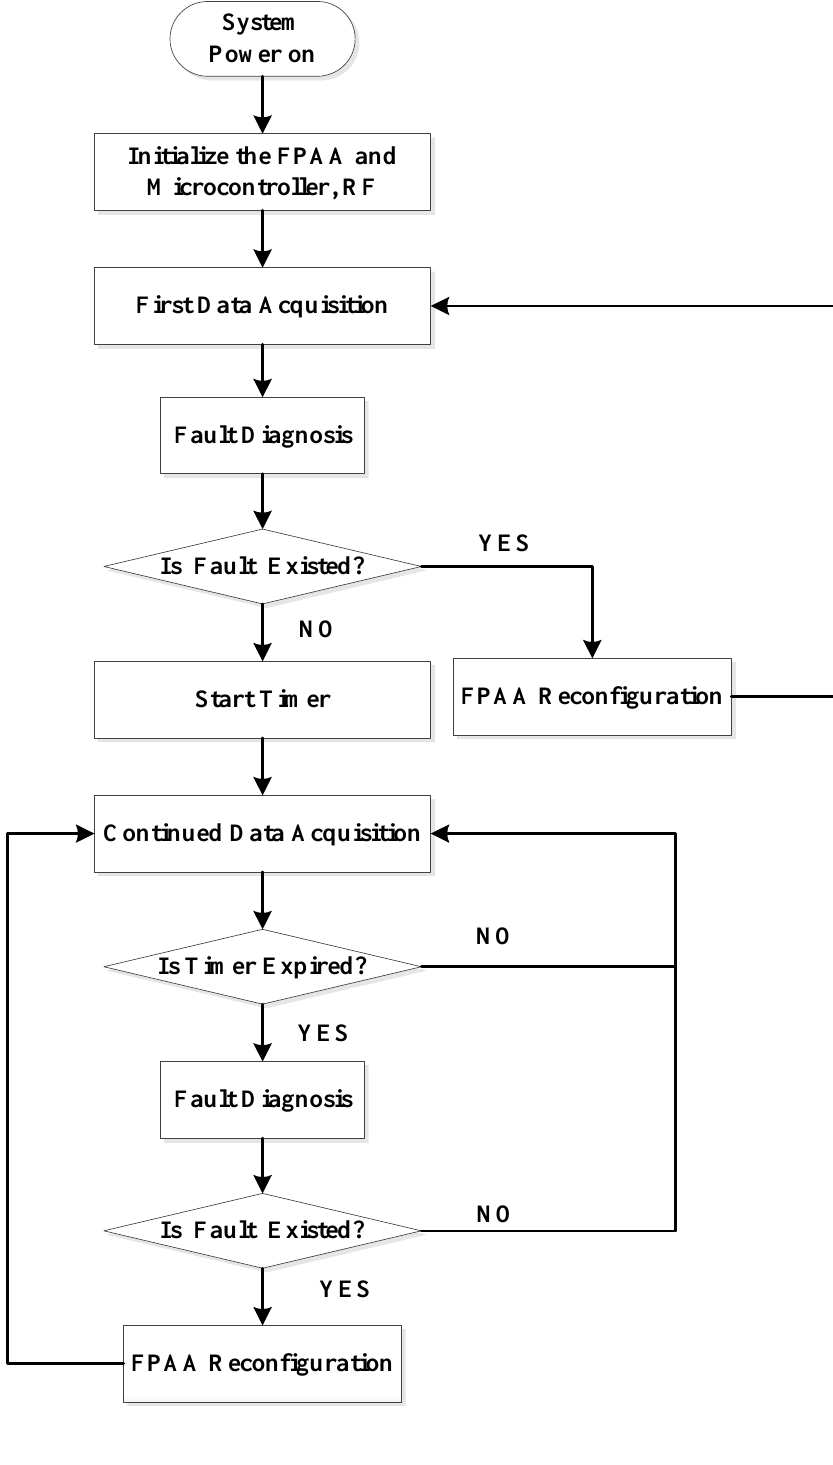
Figure 8. Software in MSP430 on the self-healing